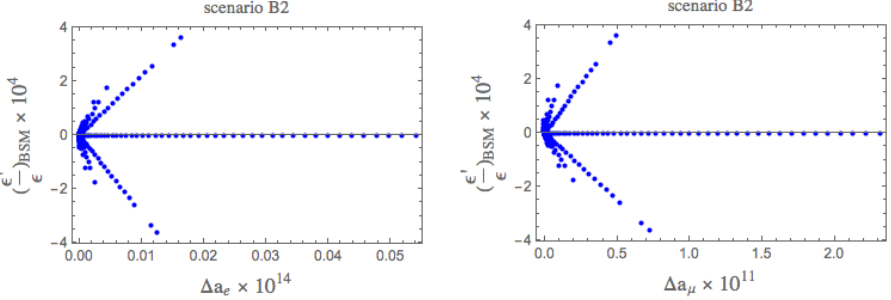
Figure 15 . Scenario B2. Correlation between NP contributions to " 0 =" and a e (left plot) and a (cid:22) (right plot).